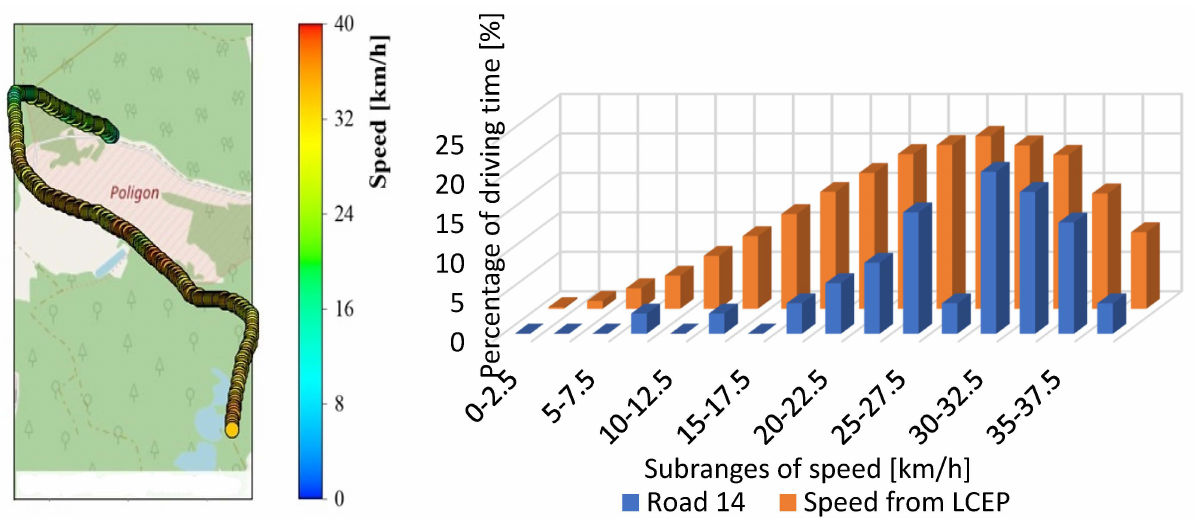
Figure 7. Speed over Road 14 ( left ) and speed distribution ( right ).